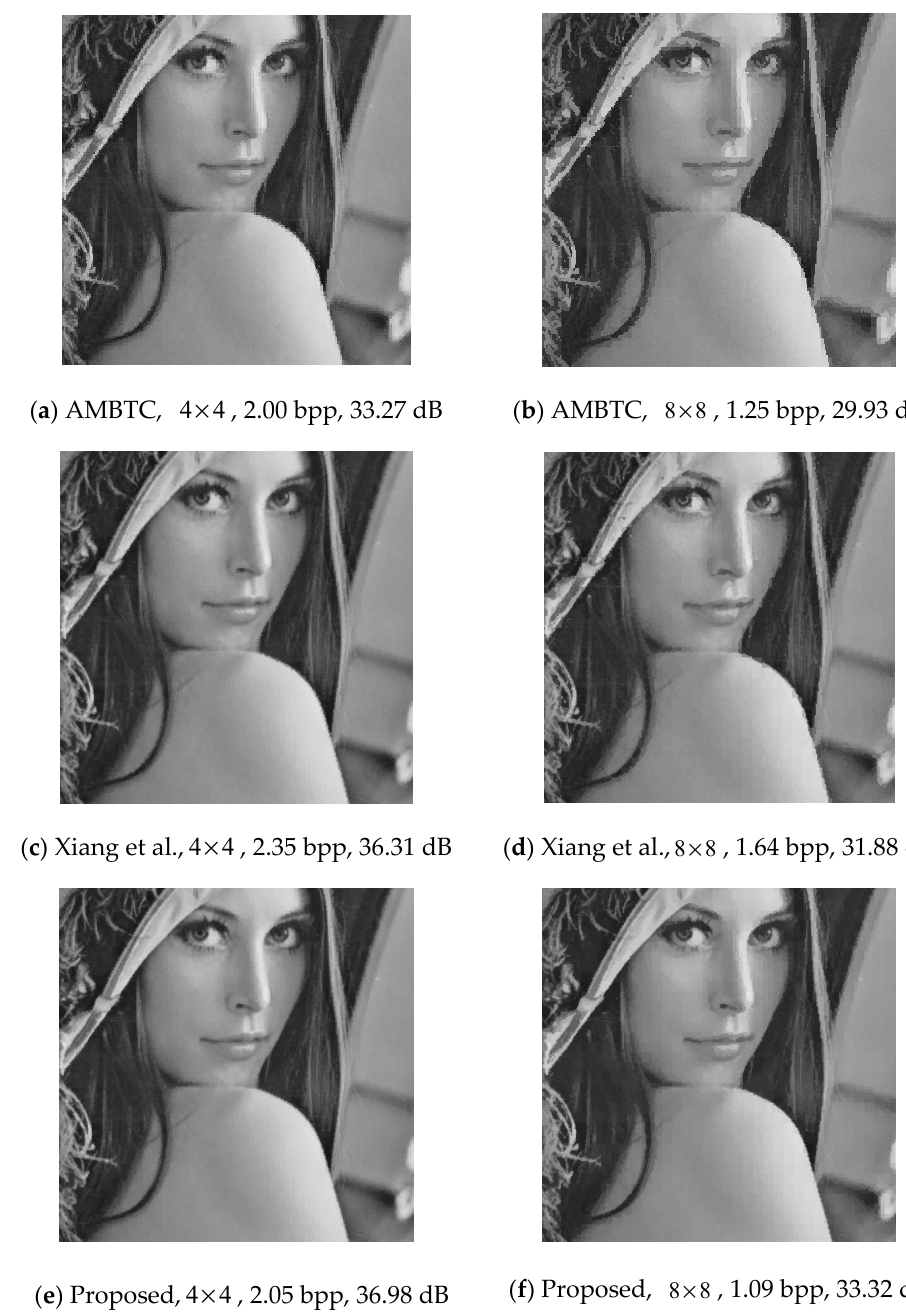
Figure 8. Visual quality comparisons of the proposed method and that of Xiang et al.